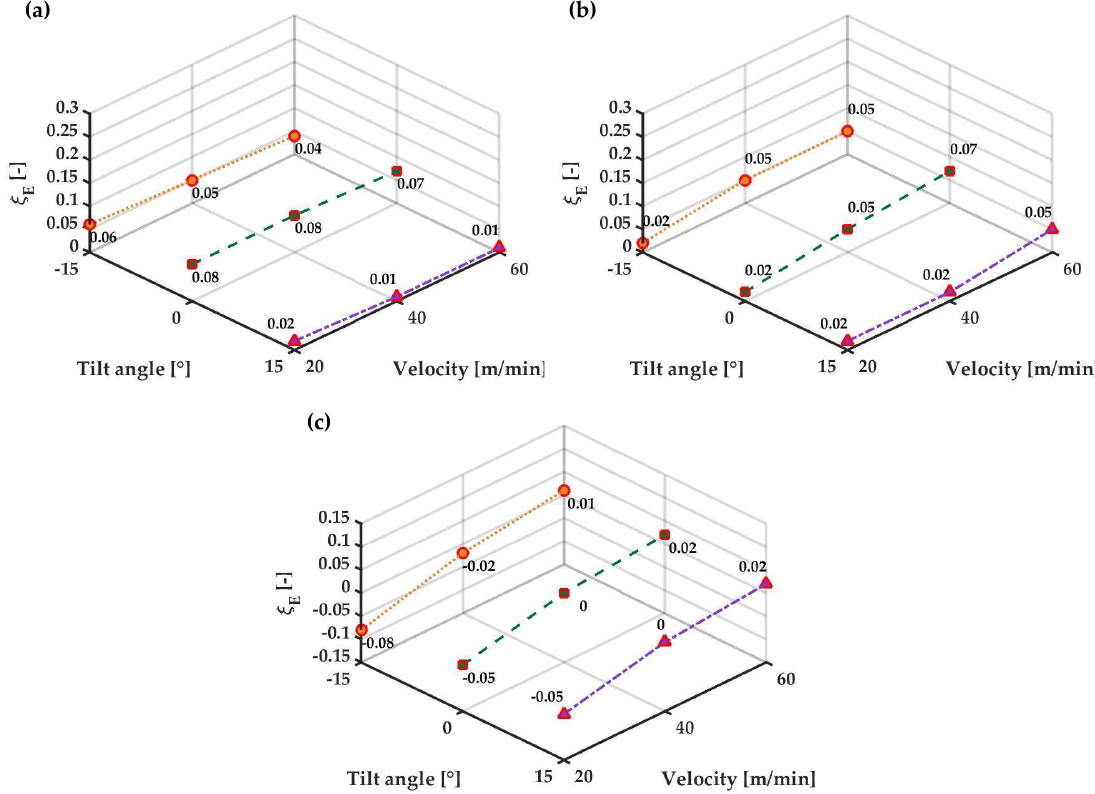
Figure 12. Energy effectiveness coefficient at section α for AC mass flow inlet ( a ) 3%; ( b ) 5%; ( c ) 7%.